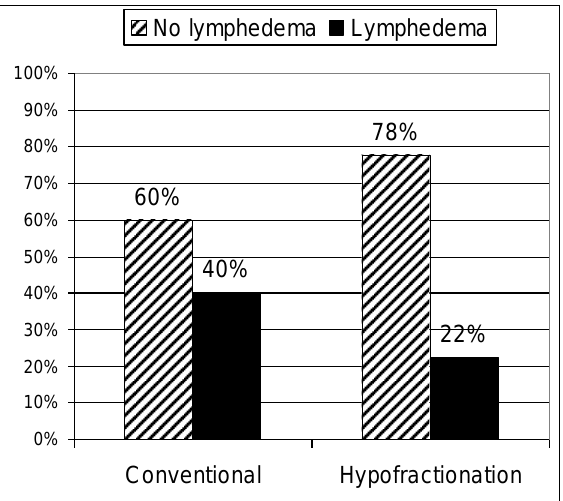
Figure 4: The rate of arm lymphedema (conventional vs. hypofractionated